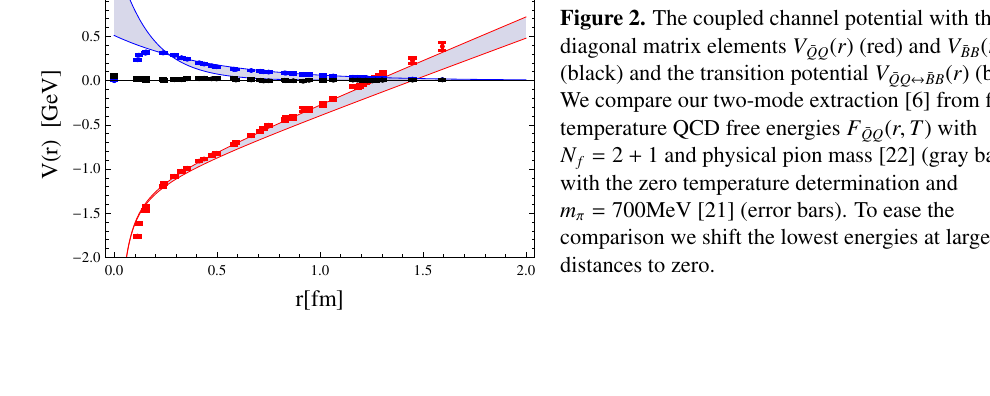
Figure 2. The coupled channel potential with the diagonal matrix elements V ¯ QQ ( r ) (red) and V ¯ BB ( r ) (black) and the transition potential V ¯ QQ ↔ ¯ BB ( r ) (blue). We compare our two-mode extraction [6] from finite temperature QCD free energies F ¯ QQ ( r , T ) with N f = 2 + 1 and physical pion mass [22] (gray bands), with the zero temperature determination and m π = 700MeV [21] (error bars). To ease the comparison we shift the lowest energies at large distances to